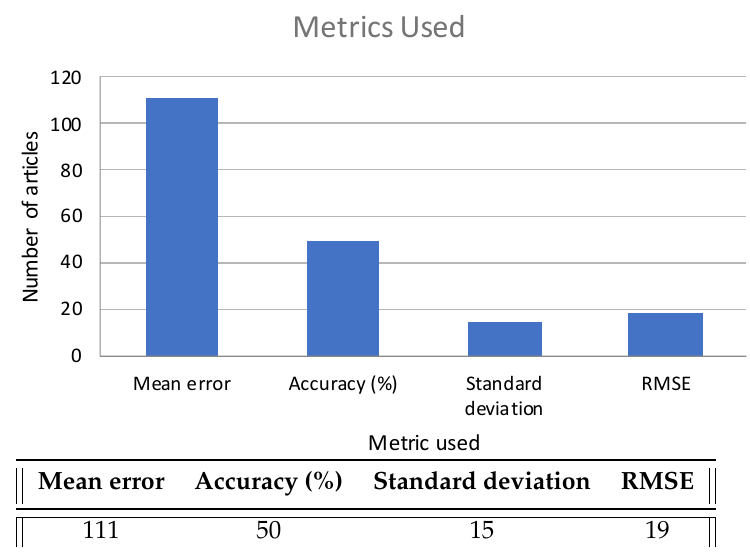
Figure 6. Metrics